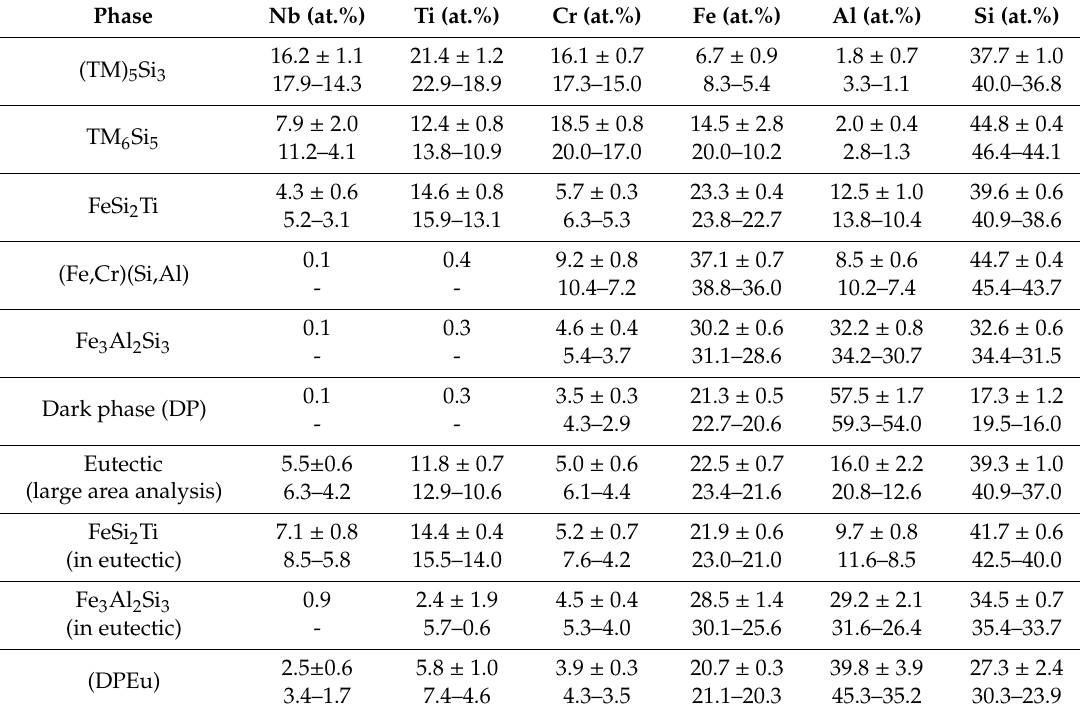
Table 1. EDS data* (at.%) of the phases in the cast alloy OHC2.